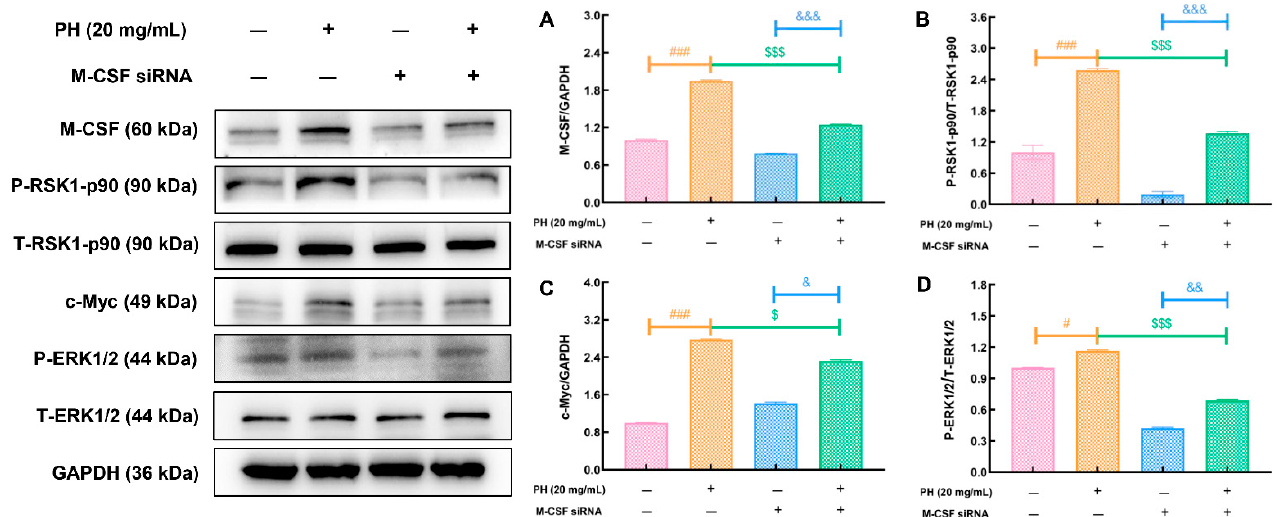
Figure 5. The regulation of PH on the expression of hematopoiesis-related proteins were partially abolished by M-CSF- siRNA transfection in K562 cells. The enhancement of PH on the expressions of ( A ) M-CSF, ( B ) P-RSK1-p90, ( C ) c-Myc, and ( D ) P-ERK1/2 in K562 cells were strongly abolished by M-CSF-siRNA transfection. Data are showed as the mean ± SD ( n = 5 samples in triplicate) and analyzed via a one-way ANOVA test followed by a Tukey’s post hoc test comparison. Quantification data were normalized by GAPDH, and reported as the folds of those from the corresponding control cells. # p < 0.05 and ### p < 0.001 vs. control group, $ p < 0.05, $$$ p < 0.001 vs. 20 mg/mL of PH treated K562 cells, & p < 0.05, && p < 0.01, &&& p < 0.001 vs. M-CSF-siRNA treated K562 cells. CTX, cyclophosphamide; Ctrl, control; Model, hematopoietic dysfunction model; rhG-CSF, recombinant human granulocyte colony-stimulating factor; PH, Protein hydrolysate injection; M-CSF, macrophage colony stimulating factor; IL-2, interleukin-2; P-RSK1-p90, p90 ribosomal S6 kinases 1; P-ERK1/2, extracellular regulated protein kinases 1/2.